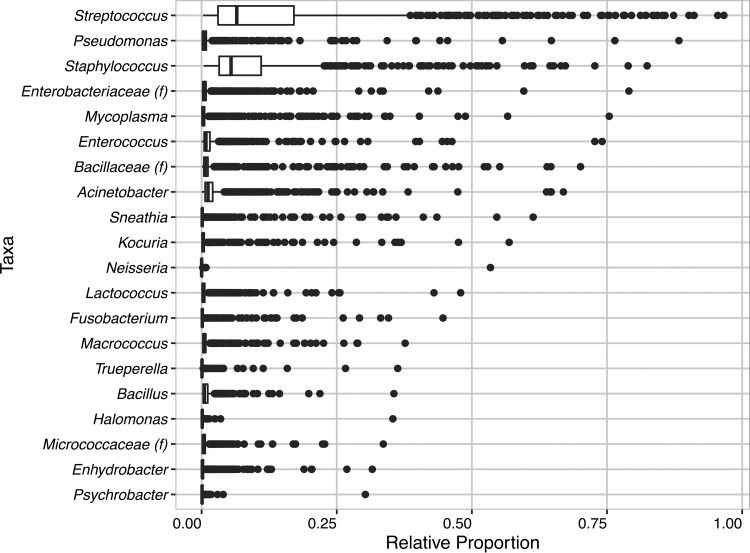
Variations in the proportions of predominant bacteria taxa in raw milk delivered to two dairy production facilities in California. Data represent relative abundances of taxa found at 30% or greater relative abundance in at least one raw tanker milk sample. Relative abundances were calculated after rarefaction of the OTU table to 15,000 sequences per sample. (f), family.